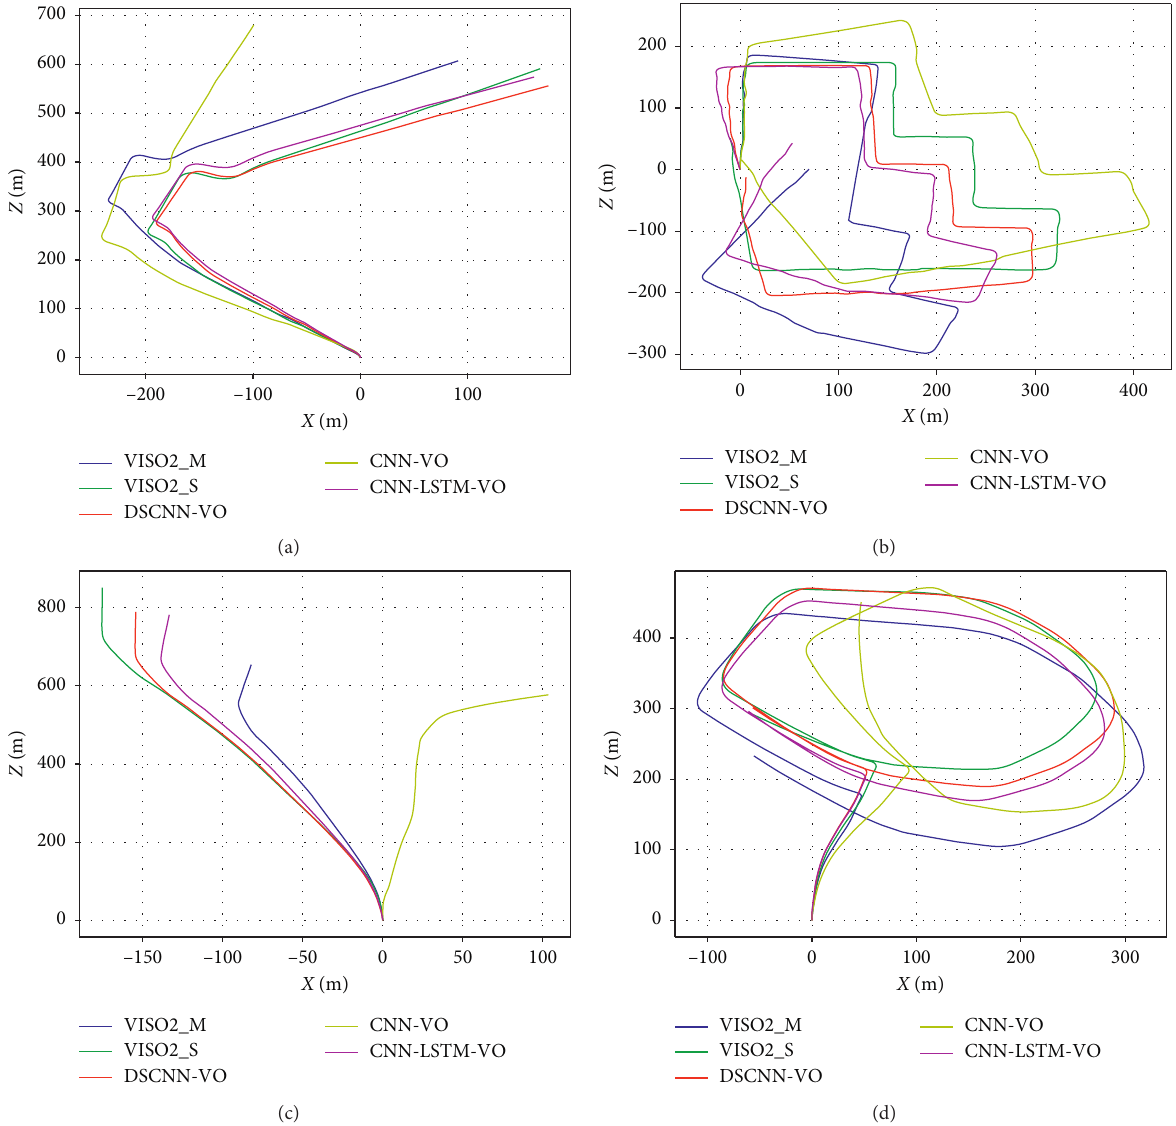
Figure 9: The qualitative experiment. The trajectories of DSCNN-VO for qualitative analysis on Sequences (a) 11, (b) 15, (c) 17, and (d) 18 without the ground truth